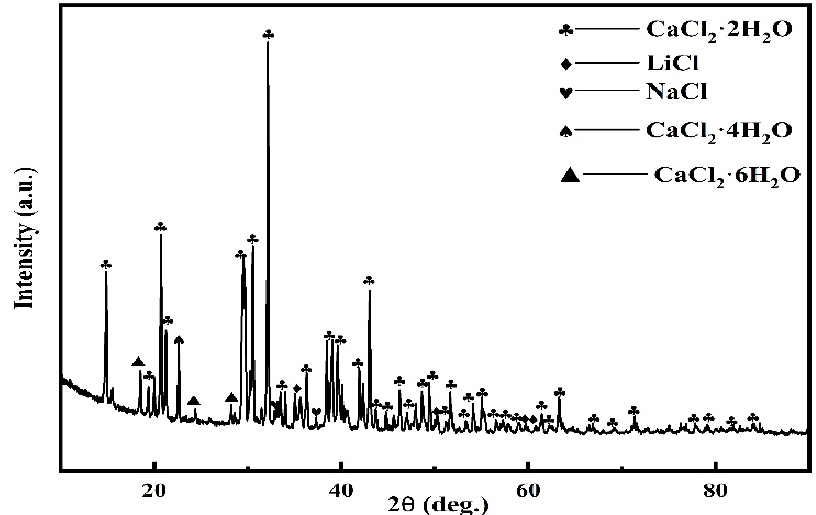
Figure 7. XRD detection of molten salt near the cathode after electrolysis.